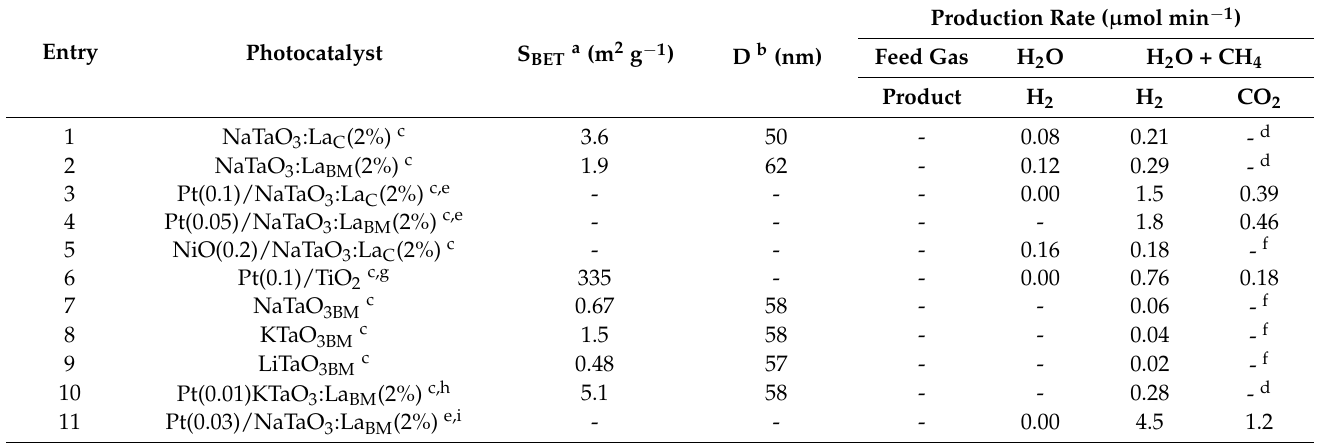
Table 3. Result of photocatalytic reaction over various samples. Reprinted with permission from [23]. Copyright (2010), American Chemical